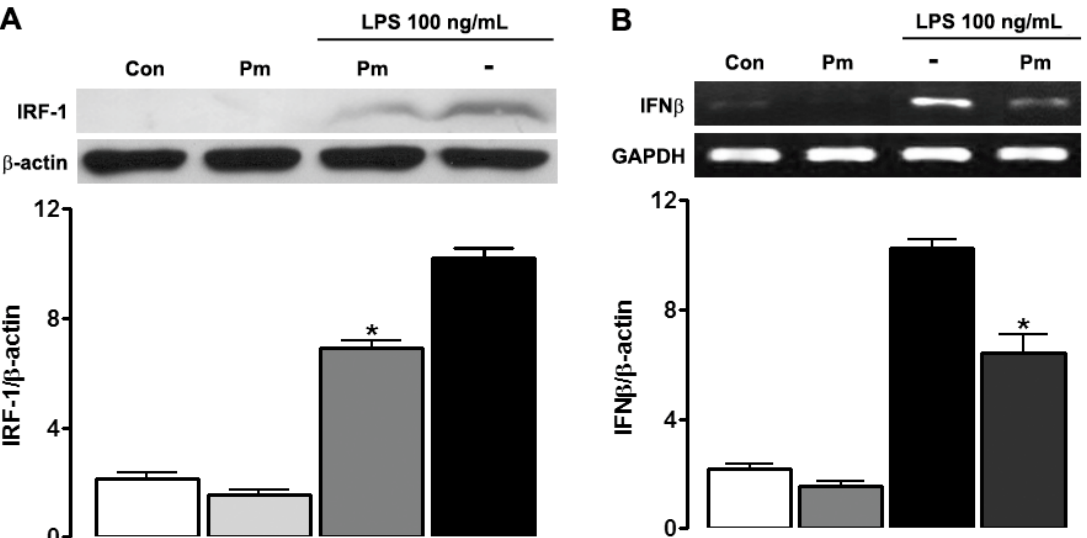
Figure 4. Effects of P. mirifica extract on LPS-induced IRF-1 protein and IFN- β mRNA expression. ( A ) HAPI cells (5 × 10 5 cells/well) were pretreated with the ethyl acetate extract of P. mirifica (100 ng/mL) for 1 h followed by stimulation with LPS (100 ng/mL) for 6 h. The expression of IRF-1 protein was evaluated by Western blot analysis. The graphs illustrate levels of expression quantitated using a densitometer. Data are representative of three separate experiments. ( B ) HAPI cells (5 × 10 5 cells/well) were treated with 100 ng/mL P. mirifica extract before LPS stimulation for 1 h. Total RNA was harvested and subjected to semiquantitative RT-PCR. GAPDH was used as a reference for equal loading. The relative expression levels of IFN- β transcript were normalized with respect to GAPDH. Results are representative of three independent experiments. * p < 0.05 compared with the LPS-treated group.